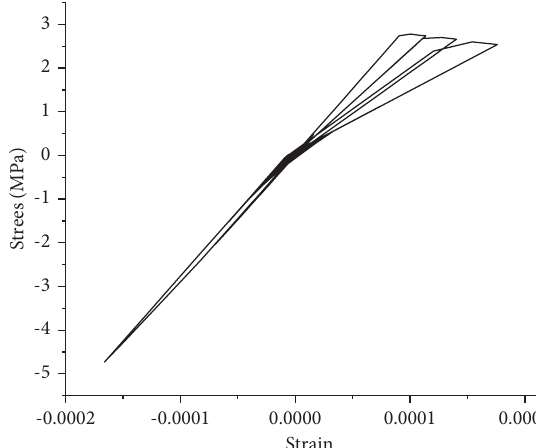
Figure 10: Stress-strain curve of concrete fber at peak value of 0.1g.